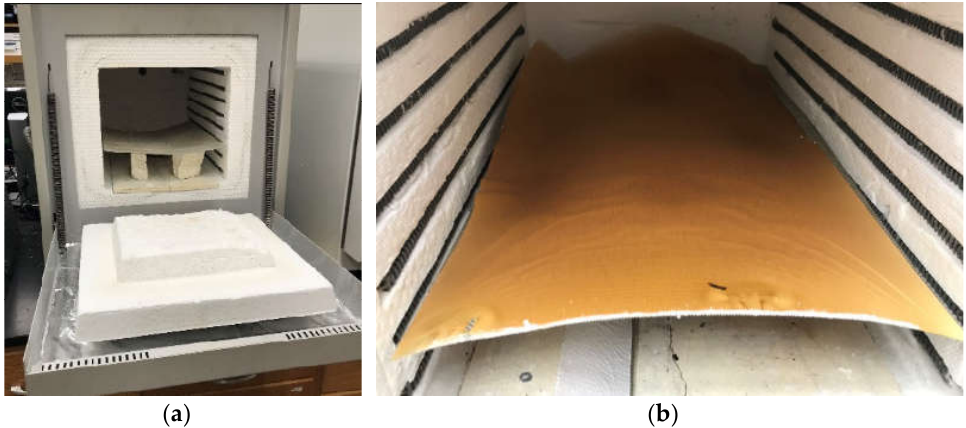
Figure 6. Stabilization of flat media. ( a ) Chamber furnace. ( b ) Stabilized flat plate (trial #3).